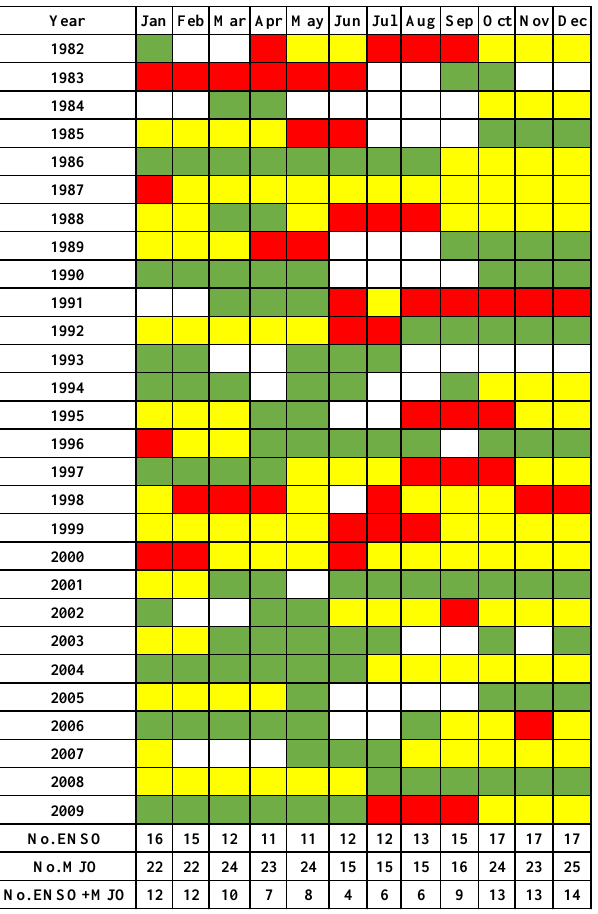
Table 4. Active ENSO, MJO, and ENSO + MJO during January 1982 to December 2009. The red areas indicate active ENSO pe- riods. The green areas indicate the periods with active MJO hap- pening. The yellow areas indicate combined active ENSO and MJO events. The last three lines show the total number of ENSO, MJO, and ENSO + MJO events for each